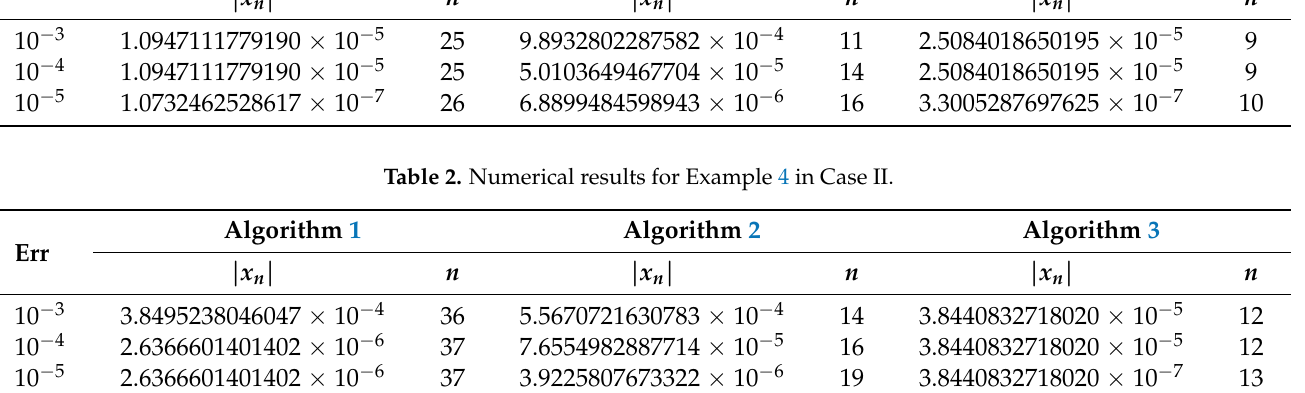
Algorithm 1 Algorithm 2 Algorithm 3